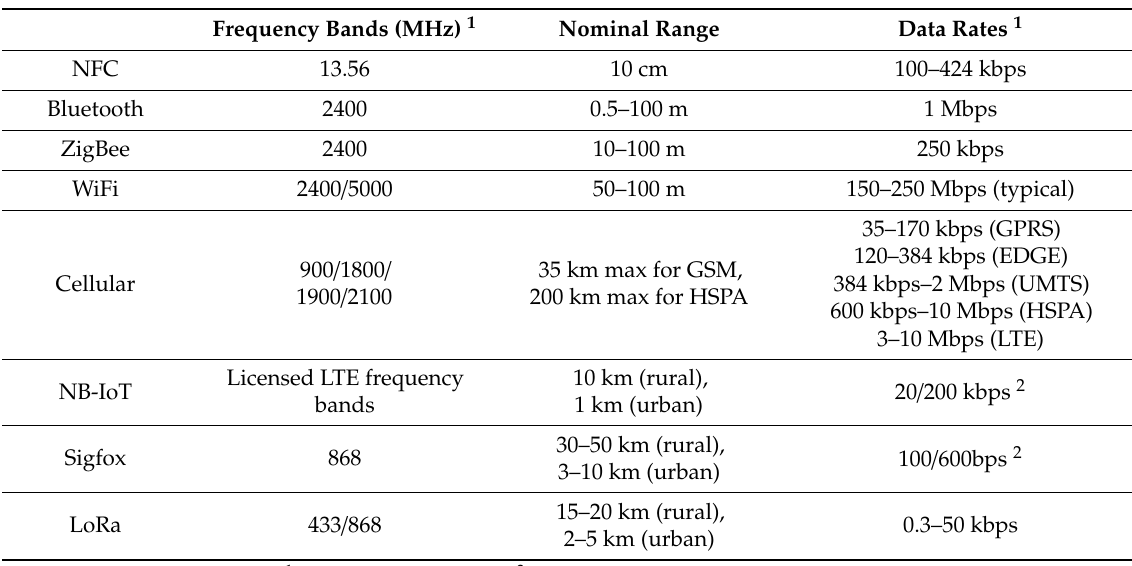
Table 1. Internet of Things (IoT) main communication